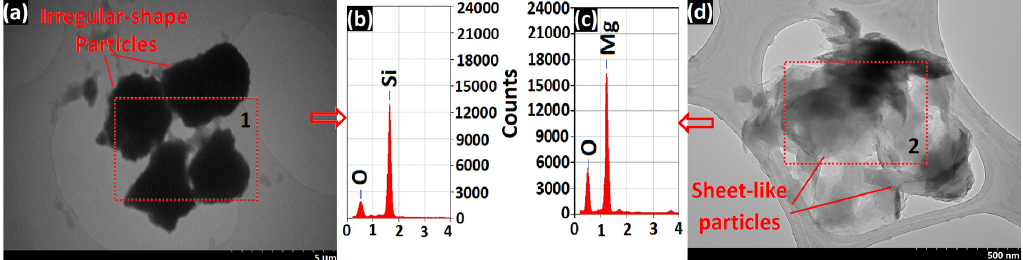
Figure 5. 3D ‐ atomic ‐ force microscopy (AFM) image of ( a ) uncoated, ( b ) MgO ‐ coated and ( c ) Si/MgO ‐ coated samples after the ball milling ‐ cold pressing ‐ sintering